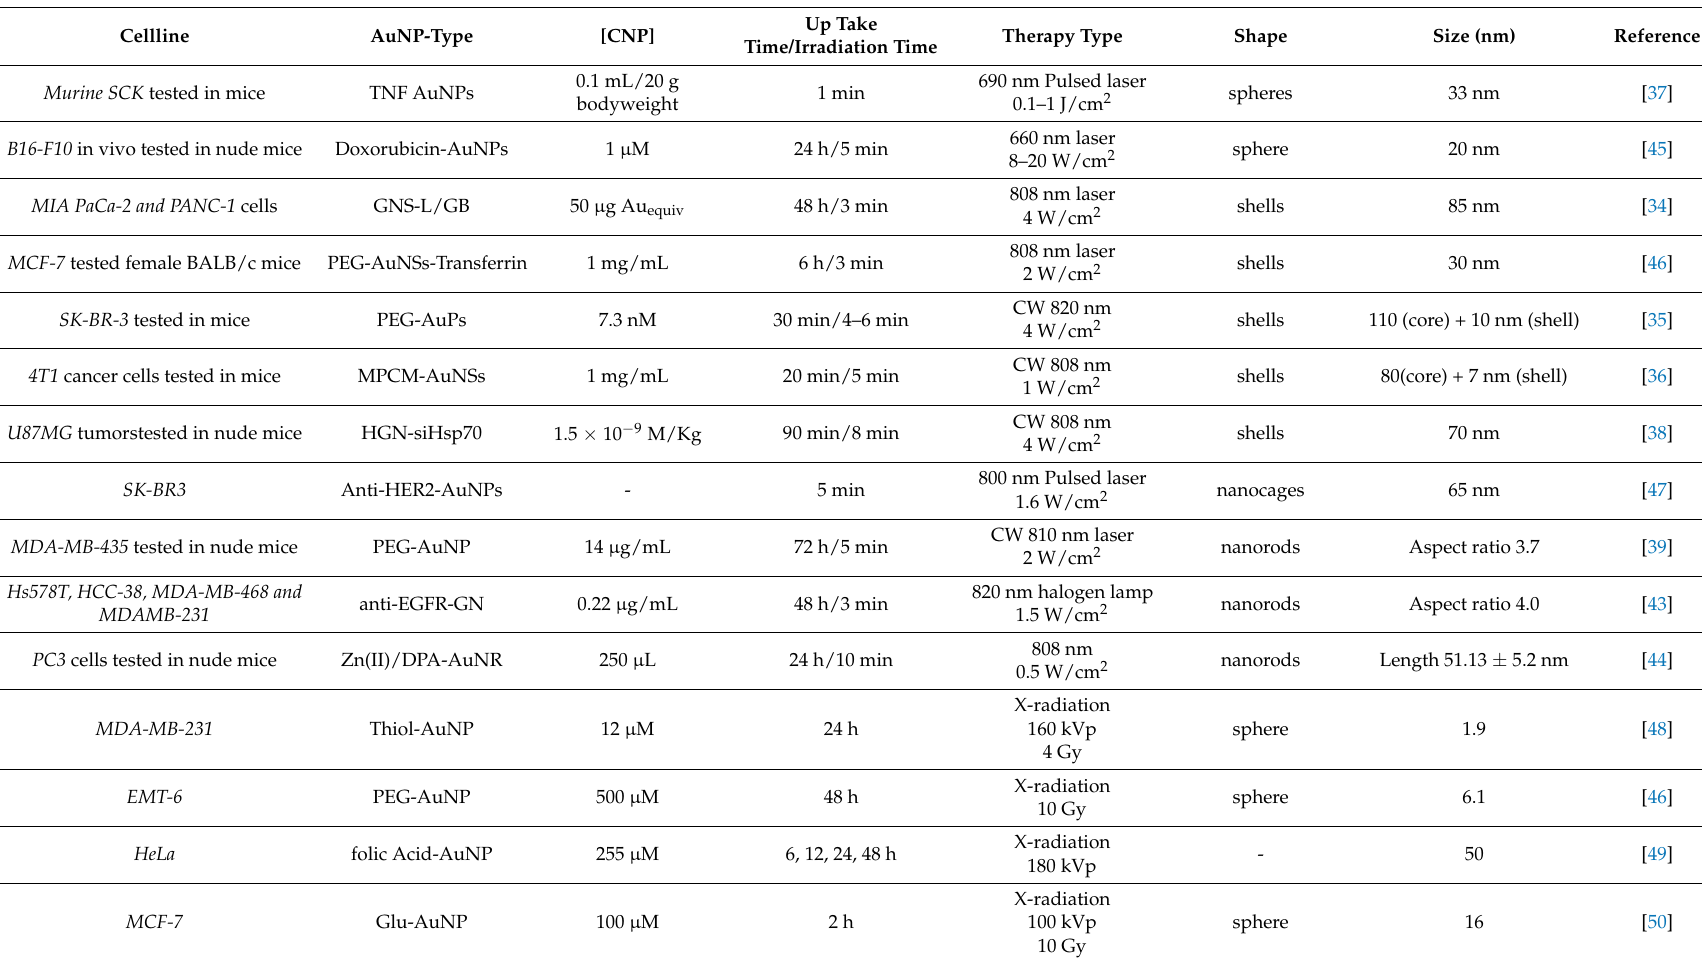
Table 1. Recent advancements in PTT, RT and PTT/RT and characteristics of testing (cells, AuNP type, concentrations, uptake time, therapy type).